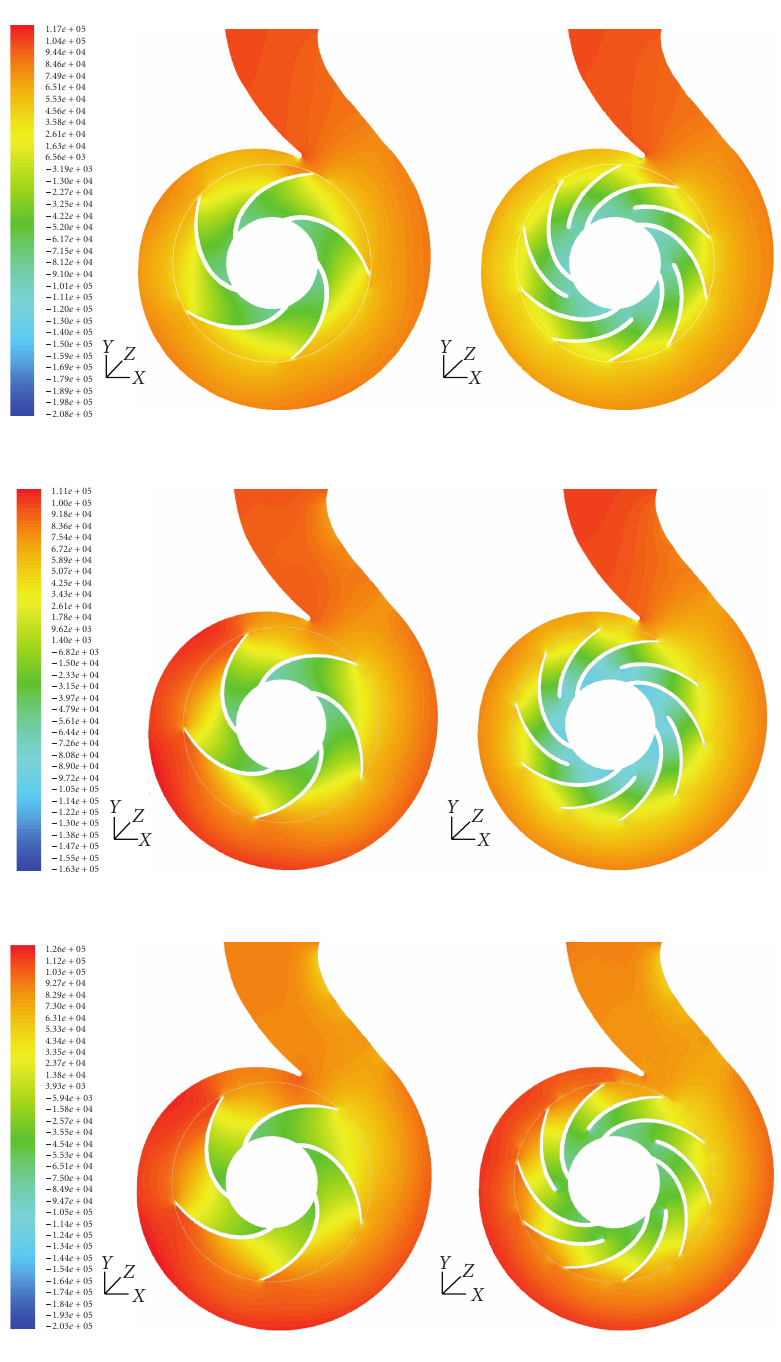
Figure 8: Computed static pressure fields at 80% (top), 100% (center), and 120% (bottom) of BEP at mean plane ( z = 0) for original (left) and splittered (right)